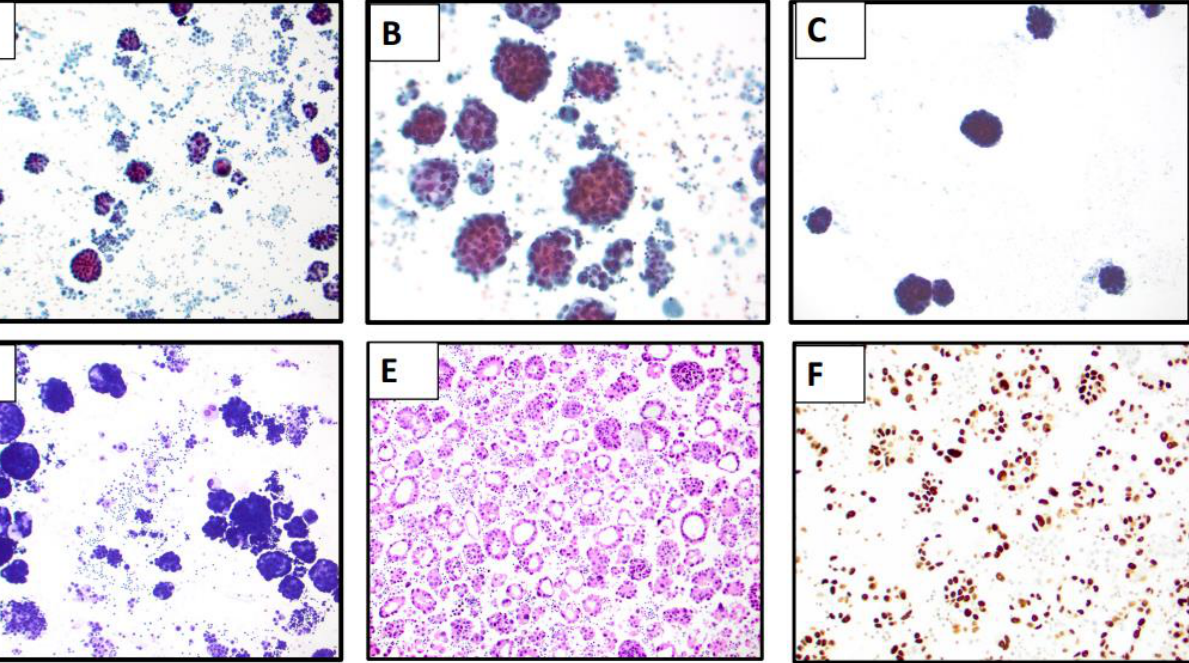
Figure 4. ( A – F ) Metastatic breast cancer in pleural fluid. ( A , B ) Malignant cells exfoliate as large spheres with smooth community borders in smears (Papanicolaou stain). Background shows reac- tive mesothelial cells and histiocytes. ( C ) ThinPrep (Papanicolaou stain). ( D ) MGG stain. ( E ) Cell block highlights hollow spheres of tumor cells, a common pattern seen in MBC. ( F ) GATA-3 shows positive staining in tumor cells, whereas mesothelial cells and histocytes present in background are